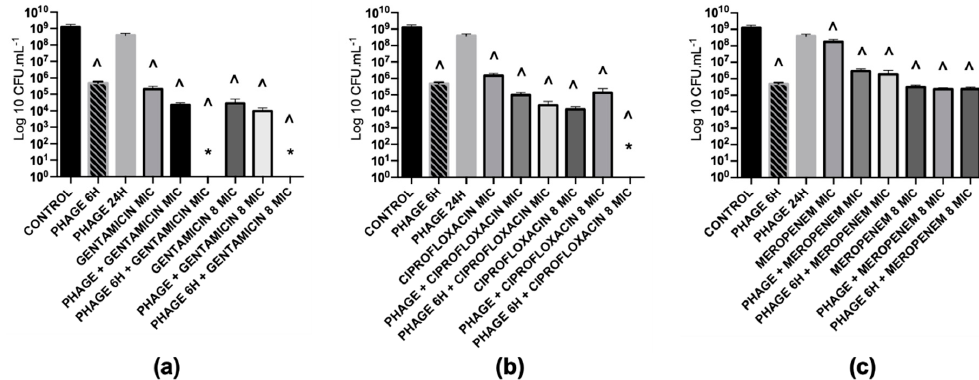
Figure 2. Treatment of P. aeruginosa PAO1 48 h biofilms with different antimicrobial agents individually or in combinations; phage EPA1 and ( a ) gentamicin; ( b ) ciprofloxacin; and ( c ) meropenem for 24 h. A prefix PHAGE indicates EPA1 in MOI 1, 6 H and 24 Hindicates treatment time period for 6 and 24 h, MIC indicates the dose of antibiotics with 1-time MIC value of P. aeruginosa 8 × MIC indicates the dose of antibiotics with 8-times MIC value of P. aeruginosa , PHAGE + antibiotic indicates simultaneous treatment, and PHAGE 6 H+ antibiotics indicates phage was added first then antibiotic was added with 6 h delay. * Under detection limit (<10 2 ). ( ^ ) Statistical differences between the control and treated biofilms were determined by two-way repeated-measures analysis of variance (ANOVA) with a Tukey’s multiple comparison test.